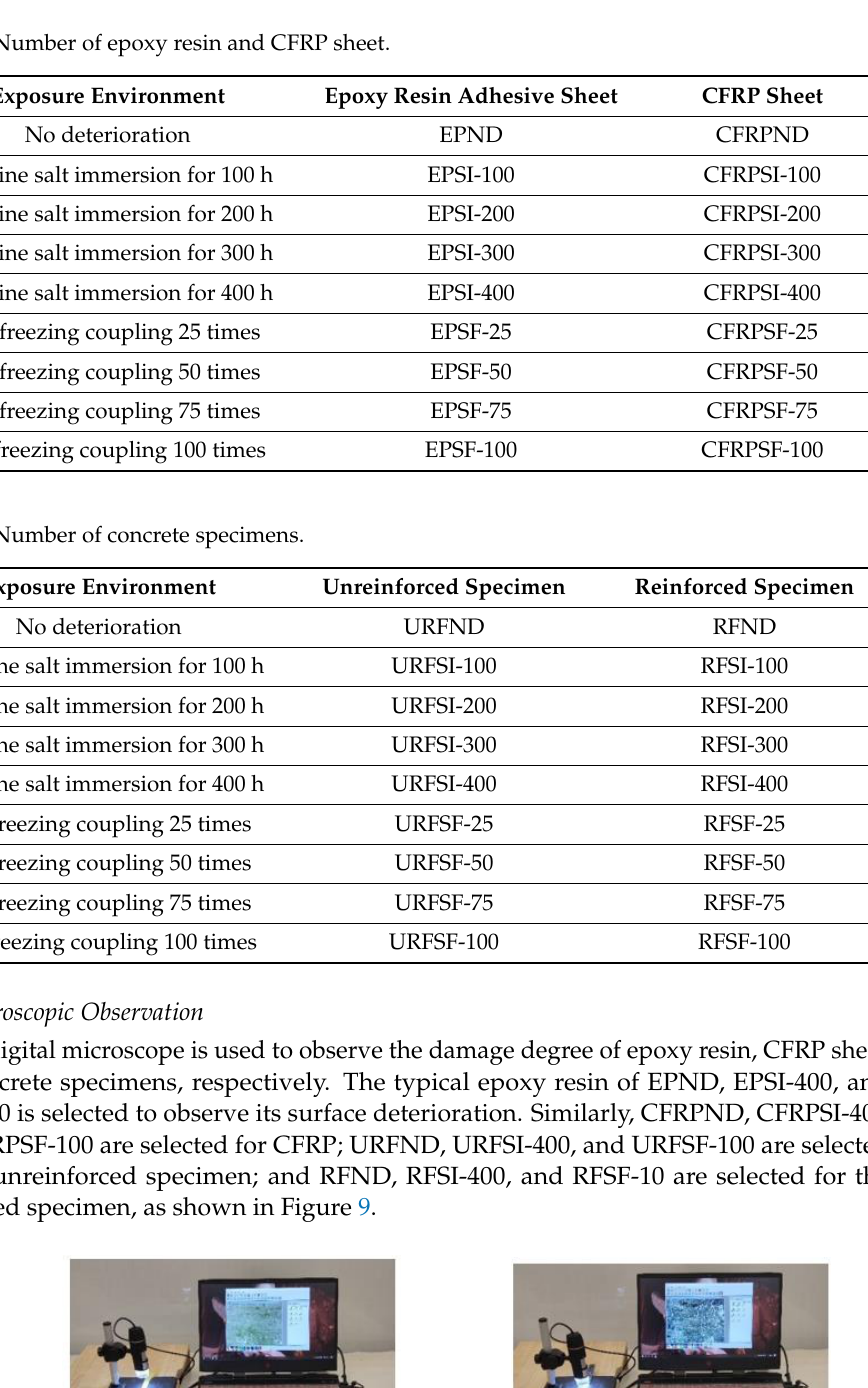
Table 3. Number of epoxy resin and CFRP sheet.